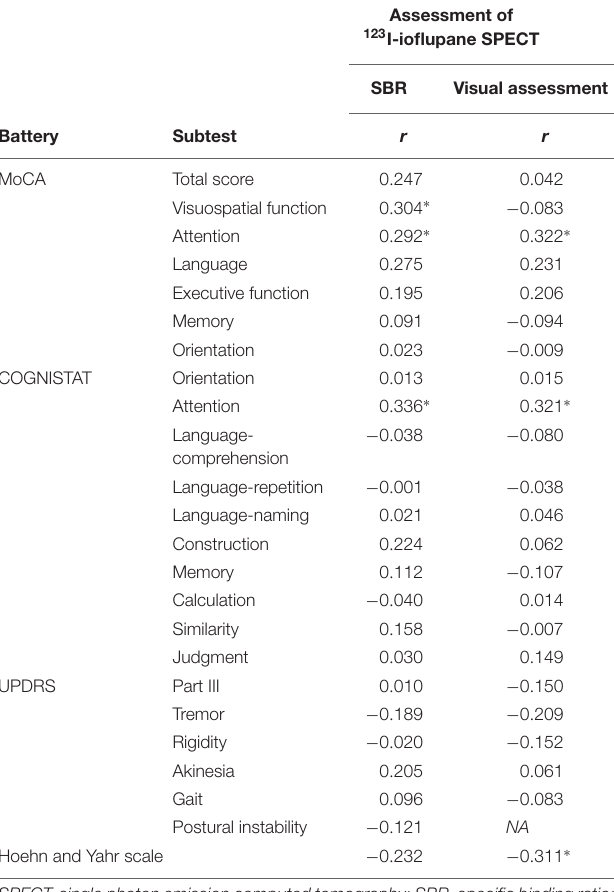
TABLE 3 | Spearman correlation coefficients for relationships of SBR and visual assessment with motor and cognitive